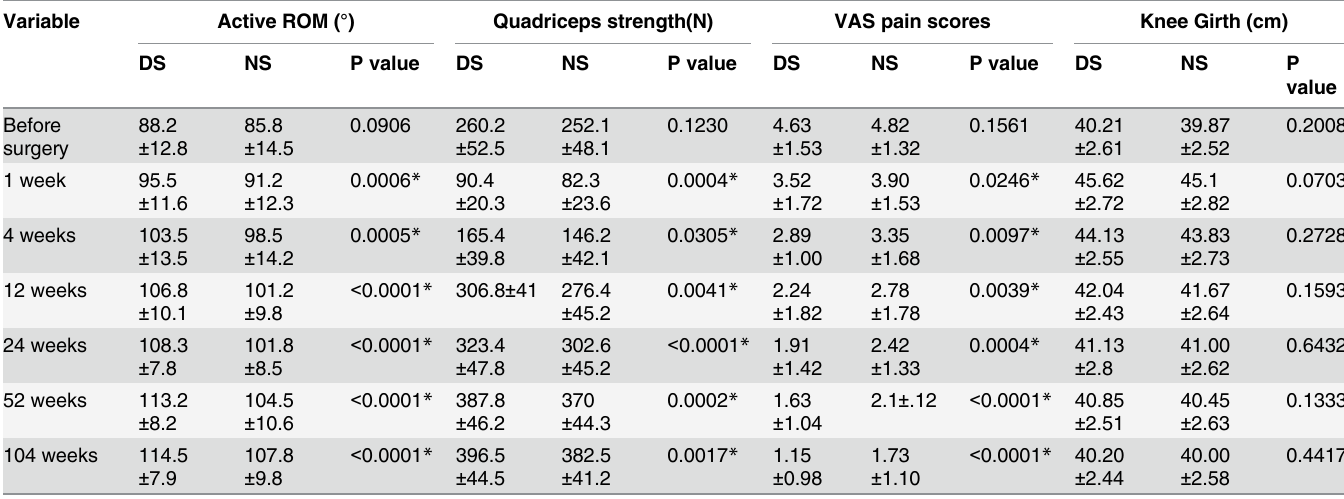
Table 2. Clinical outcomes of two sides after SBTKA.